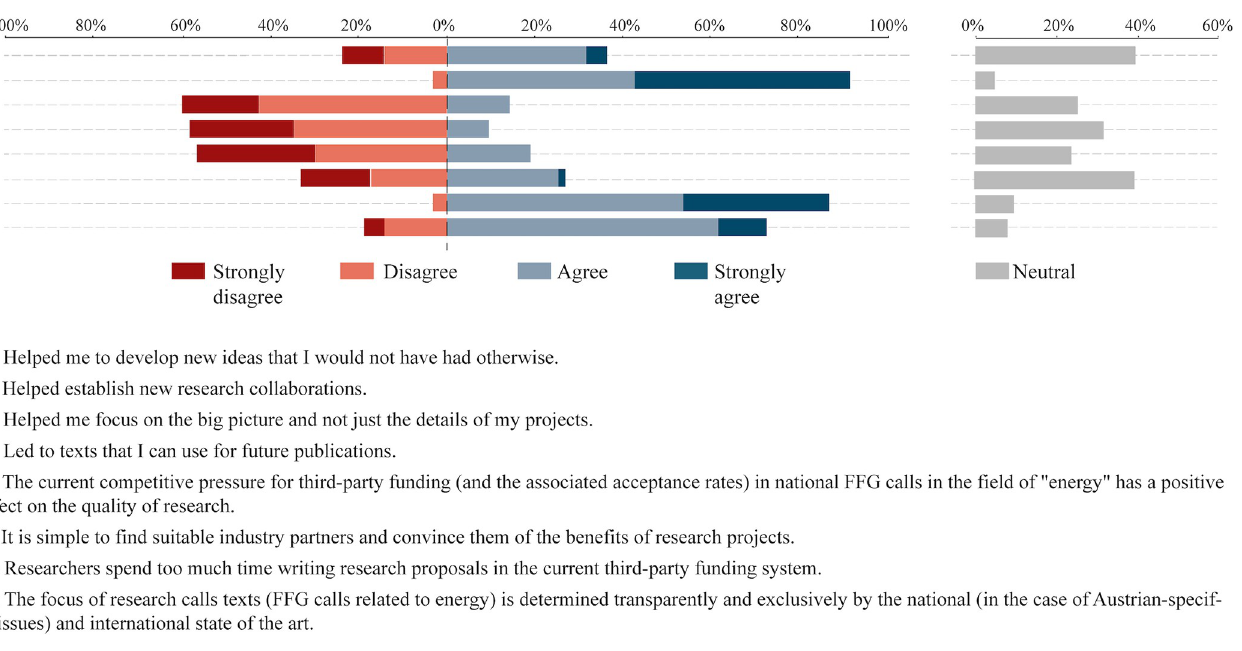
Fig 10. Responses from research based on a 5-point Likert scale.